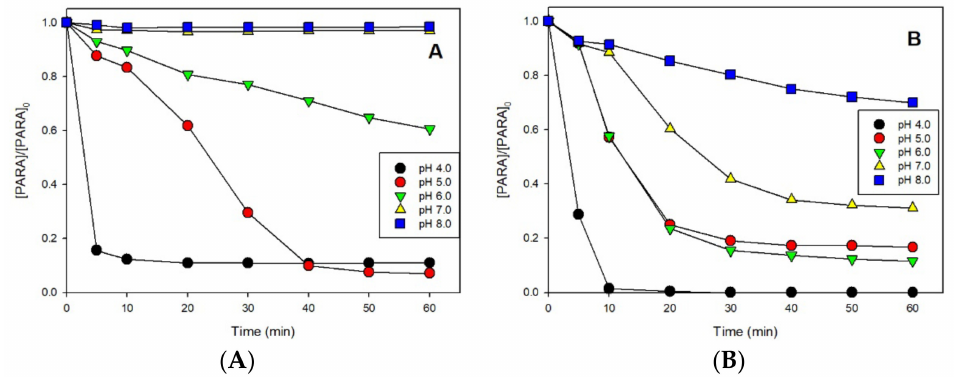
Figure 3. Effect of pH on PARA degradation under dark ( A ) and UVA ( B ) in aerated solutions. Conditions: [PARA] 0 = 10 µ M, [Fe(III)] 0 = 0.1 mM, [S(IV)] 0 = 1.0